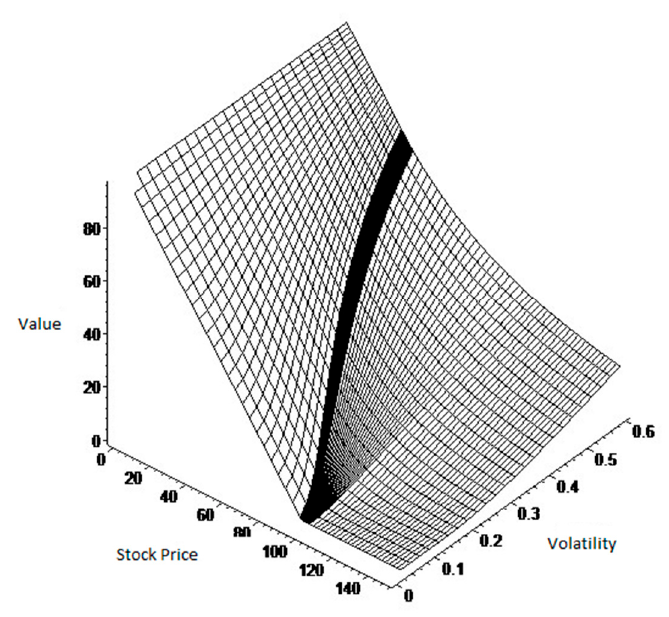
Figure 2. American put option as a function of S and σ . The values of the parameters underlying the construction of this figure are as follows: n , the number of time intervals is 2; r , the interest rate is 0.06; τ , the term remaining to maturity is 3 years; K , the strike price is 100; and φ , the value of constant dividends is 1.6.